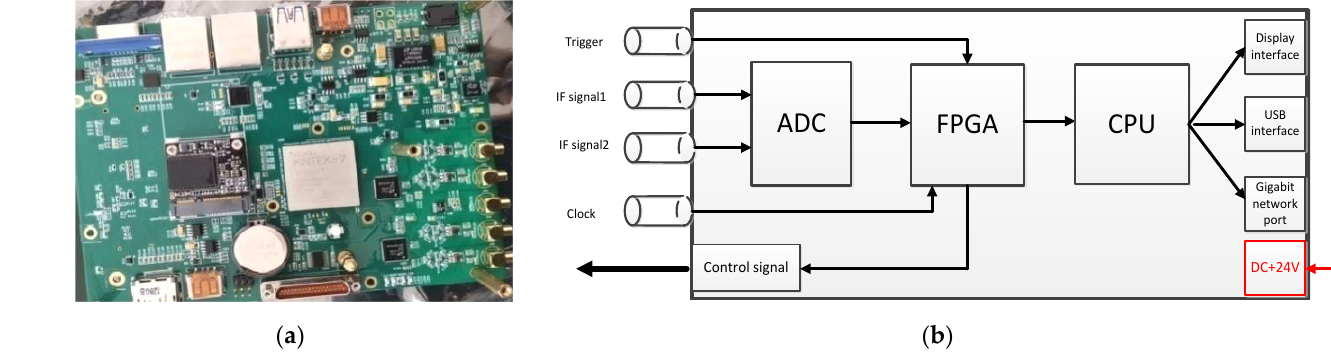
Figure 9. Data acquisition equipment: ( a )photo; ( b ) schematic diagram.